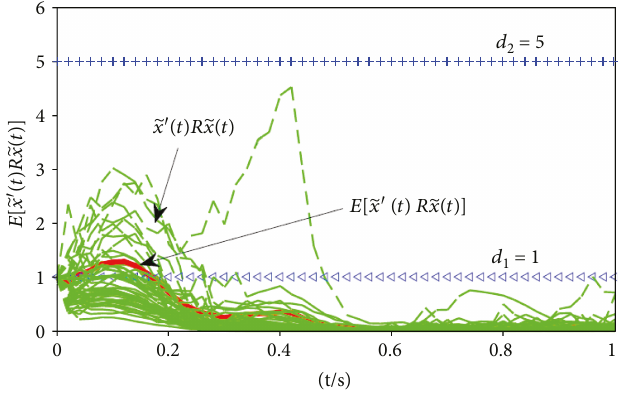
Figure 8: The response for E x ′ t Rx t